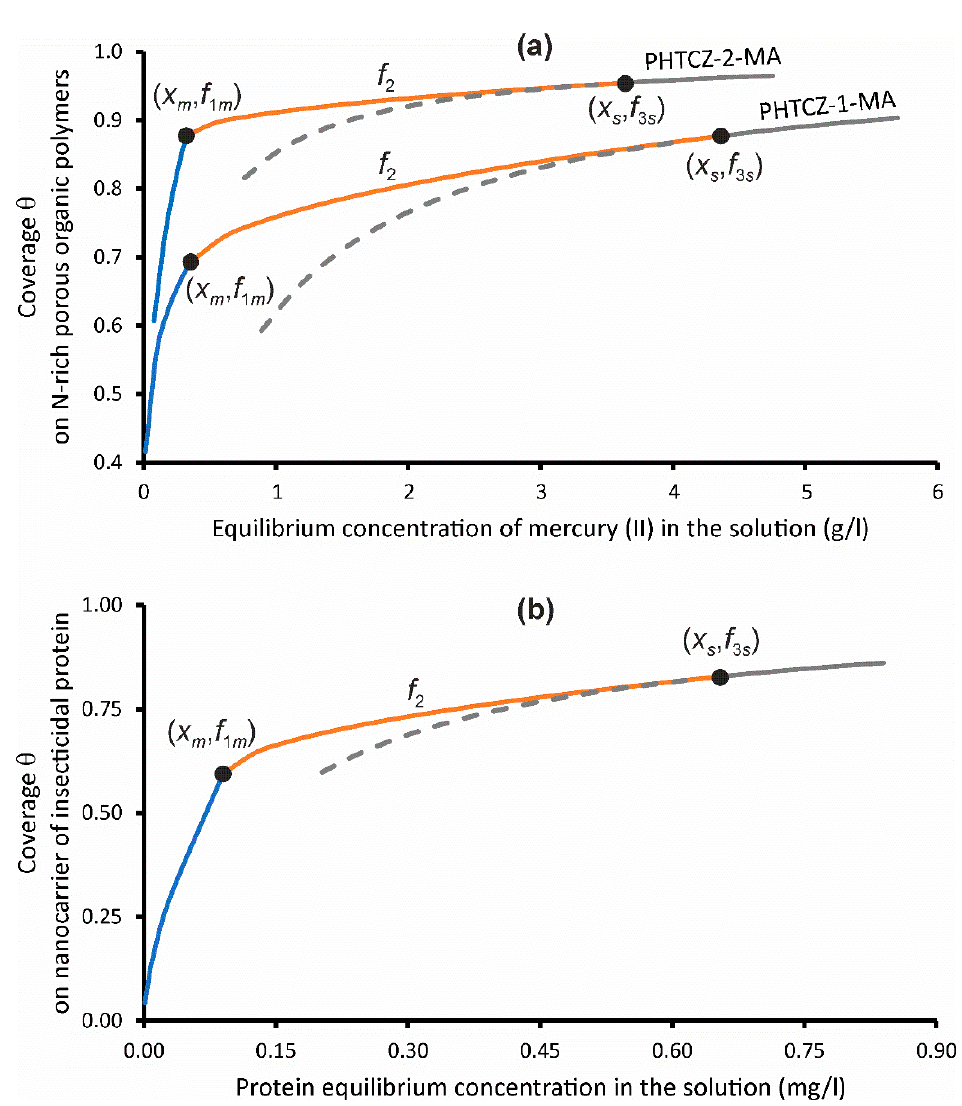
Figure 1. Freundlich isotherms in all concentration ranges. Blue f 1 ( x ): experimental data ( a ) [6]: the source graphical data were digitalised for further analysis; ( b ) [9]: available supplementary digital data were used). Grey f 3 ( x ): saturation regimes according to Equation (4). Orange f 2 ( x ): bridging the chasm for intermediate concentrations.